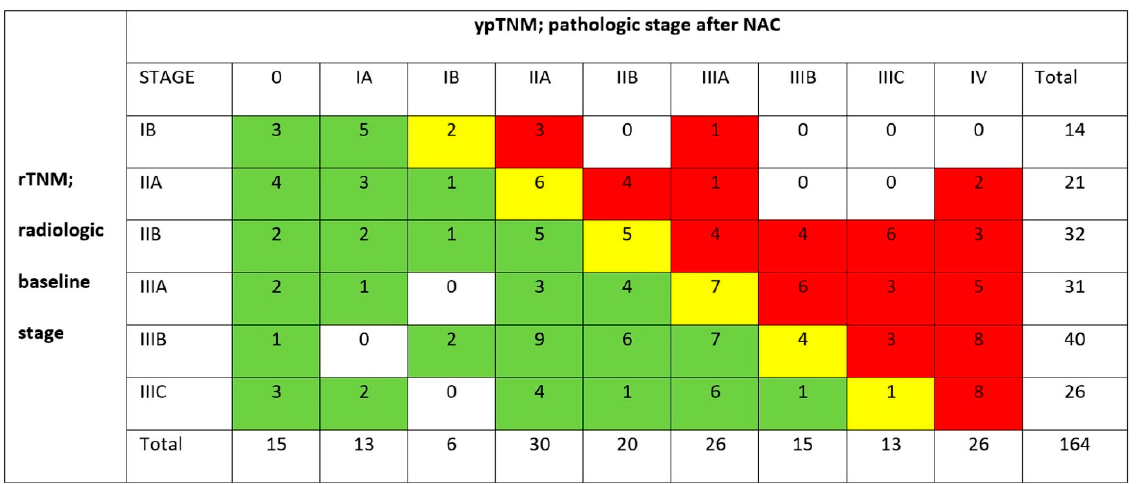
Figure 2. Cross-tabulation of the CT stage at diagnosis (rTNM) vs. the definitive pathological stage (ypTNM), n = 164. Green: response, downstaged ( n = 78); yellow: stable disease ( n = 25); red: progression, upstaged ( n = 61).